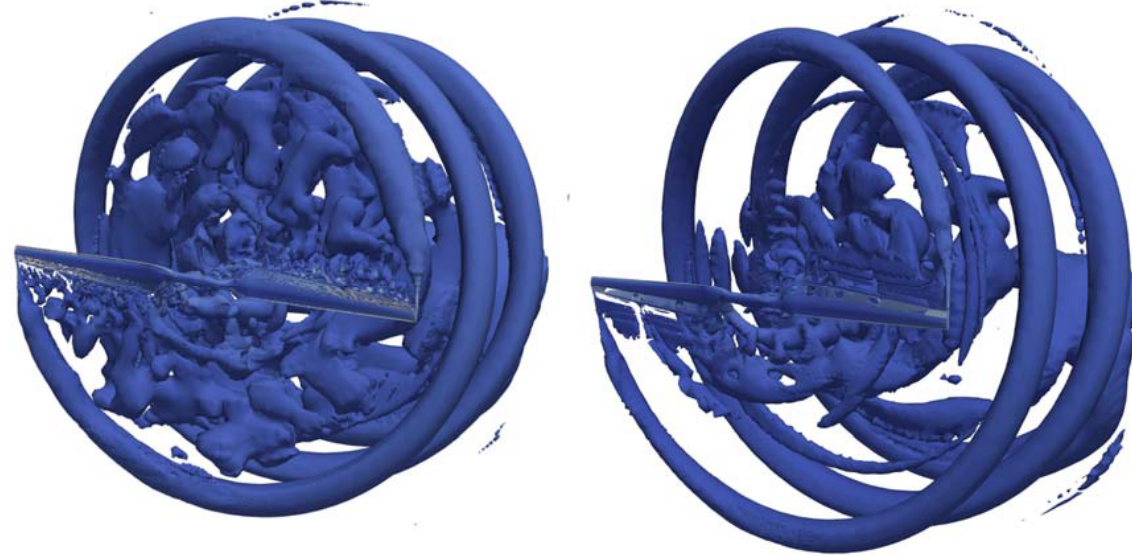
Figure 12. Vorticity contours when wind speed = 7 m/s and time = 1.2 s ( left : VLES; right : URANS).